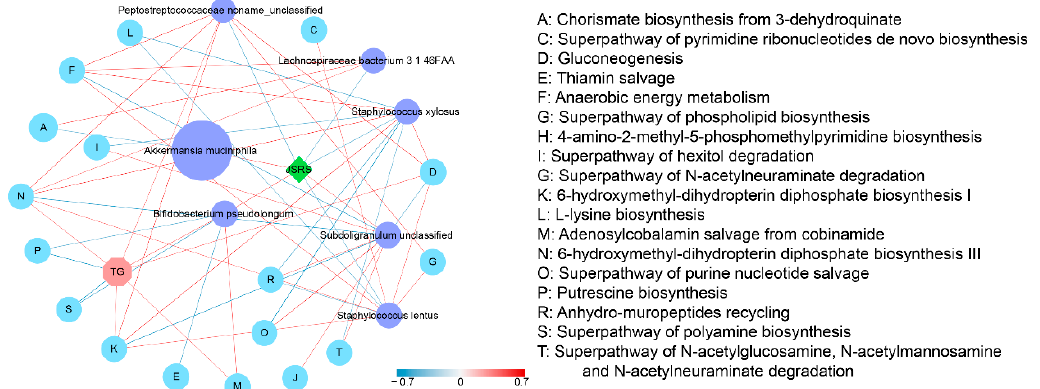
Figure 5. The correlation network among Jackfruit seed sourced resistant starch (JSRS), differential species, metabolic pathways, and TG. The R-value less than − 0.4 or greater than 0.4 was selected. The width and color (red indicates a positive correlation, while blue indicates a negative correlation) of the edge are proportional to the correlation intensity. The green node represents JSRS, purple nodes represent species, light blue nodes represent metabolic pathways, and light red nodes represent TG. The node size is proportional to the mean abundance in the respective population.